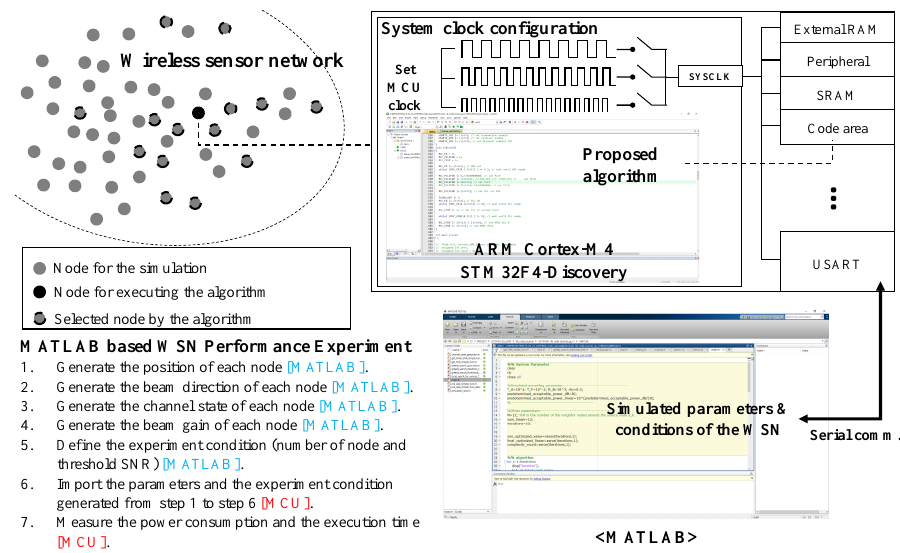
Figure 7. Operating interaction between MCU and MATLAB for emulating the proposed algorithm.